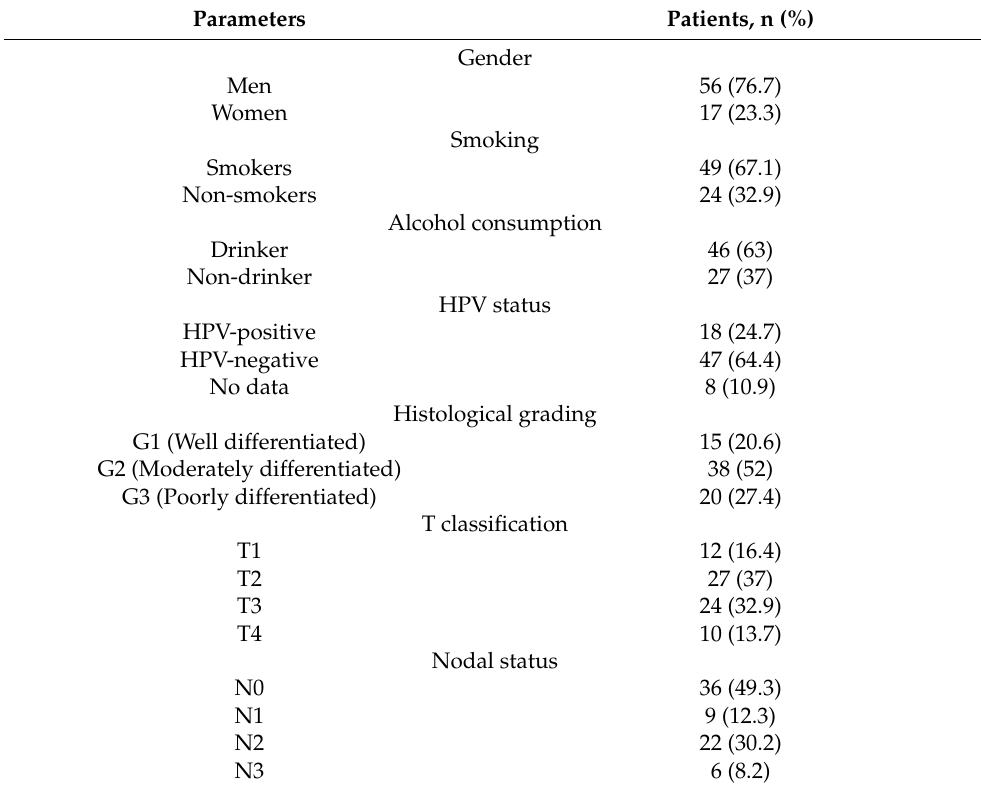
Figure 1. Diagram of the study protocol. Table 1. Parameters characterizing OSCC patients.